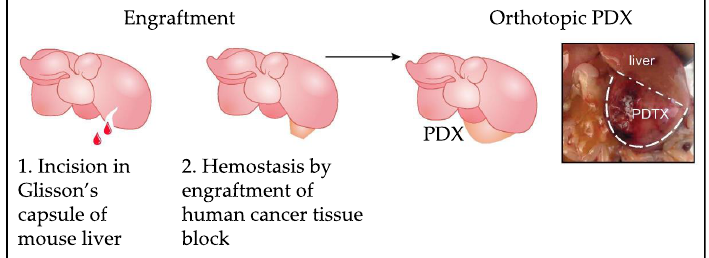
Figure 2. Implantation of whole tumor pieces onto the Glisson’s capsule of the mouse liver for generation of intrahepatic PDX HB tumors. Modified from Bissig-Choisat et al. (2016) [24].